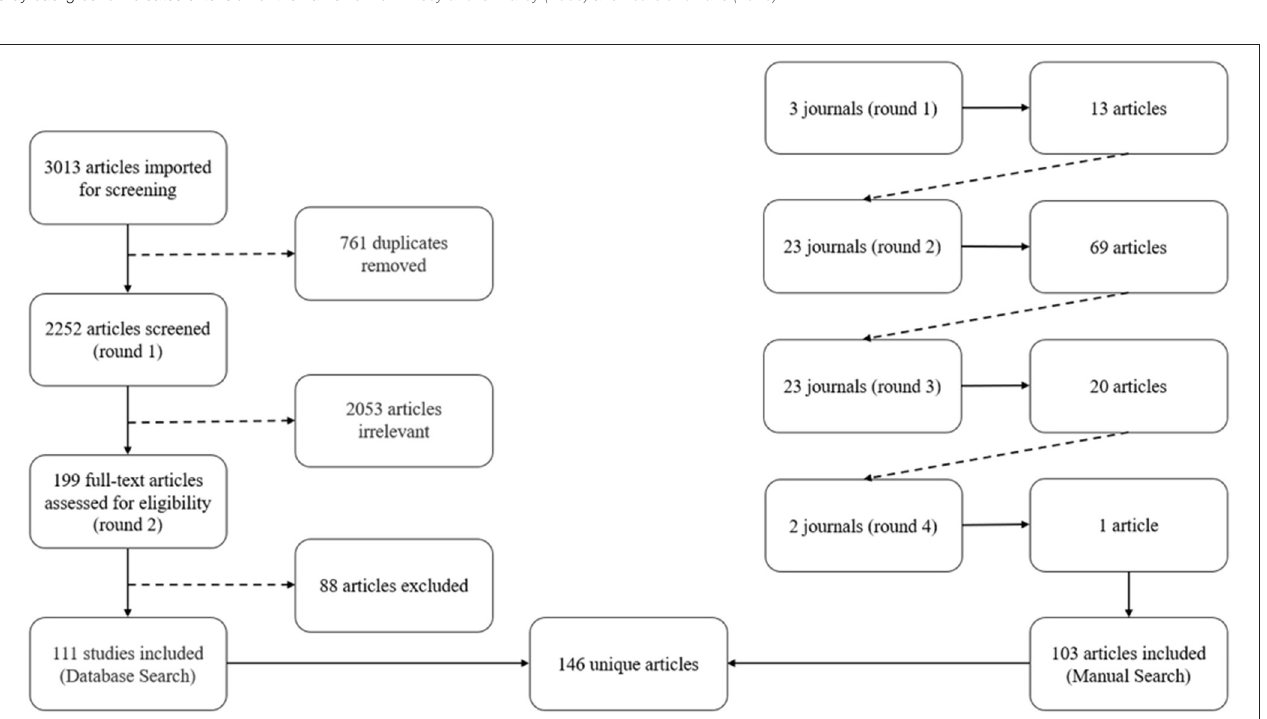
FIGURE 1 | Flow diagrams for the traditional database search and systematic manual